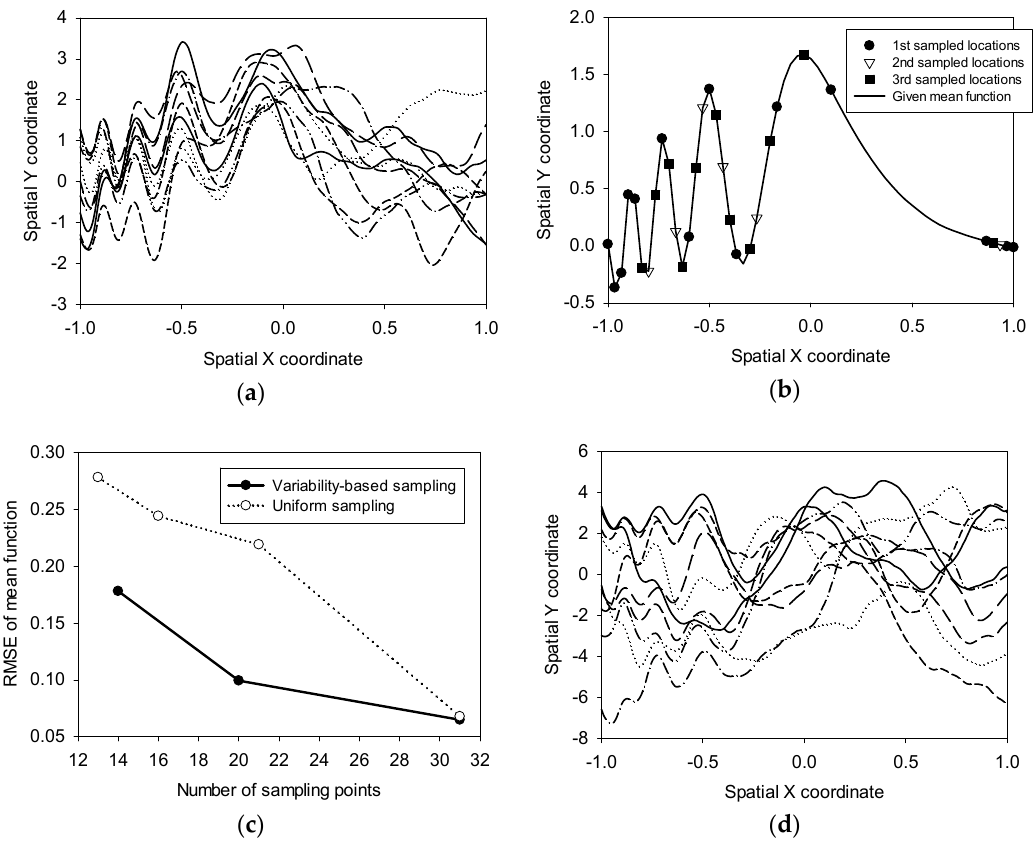
Figure 2. Given and estimated stochastic processes: ( a ) 10 realizations from the given model; ( b ) Given mean function (solid line) and sampled points in 1st (circle), 2nd (triangle), and 3rd (rectangle) runs after variability-based sampling algorithm; ( c ) root-mean-square error (RMSE) of the mean function from uniform and variability-based sampling algorithm; ( d ) 10 sampled realizations from the estimated Gaussian process model.